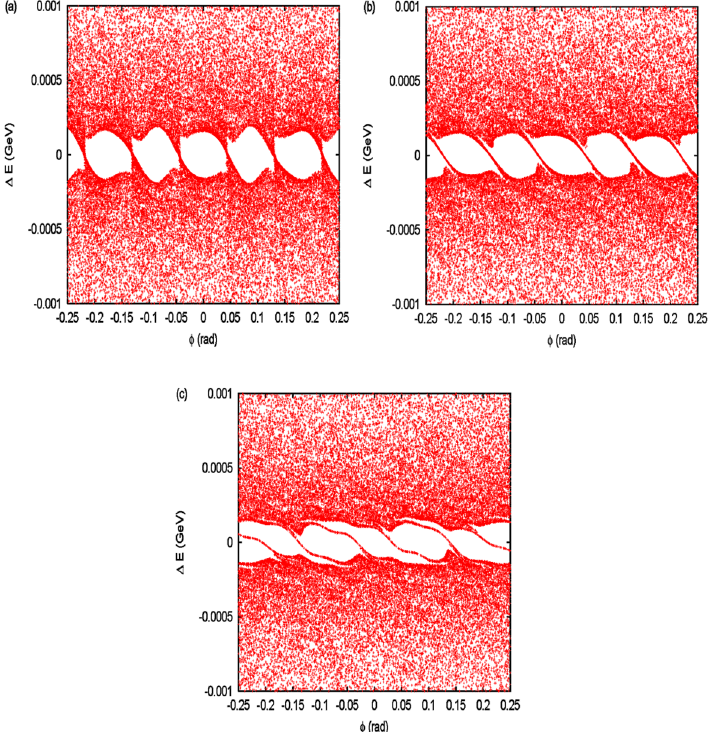
FIG. 8. (Color) (a) Longitudinal phase space of the beam at the end of injection for a 100 nC chopped beam. (b) Phase space after 250 turns of storage. (c) Phase space after 650 turns of storage.